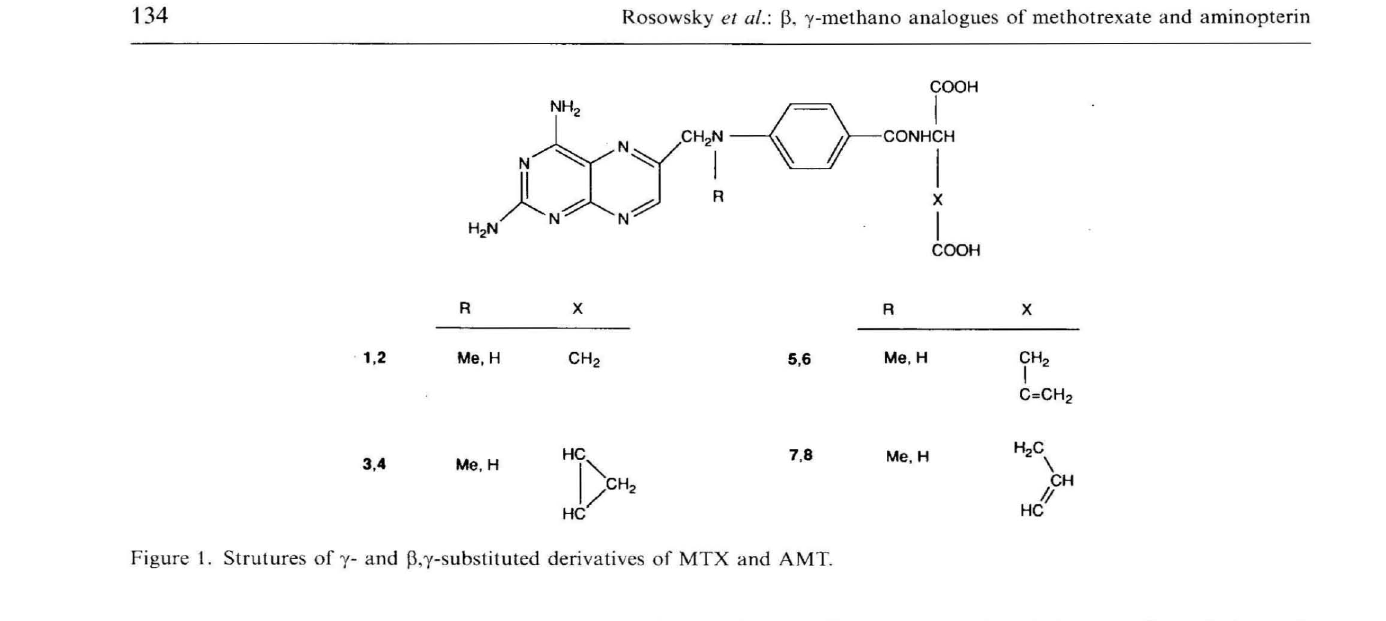
Figure 1. Strutures of y- and [3,y-substituted derivatives of MTX and AMT.